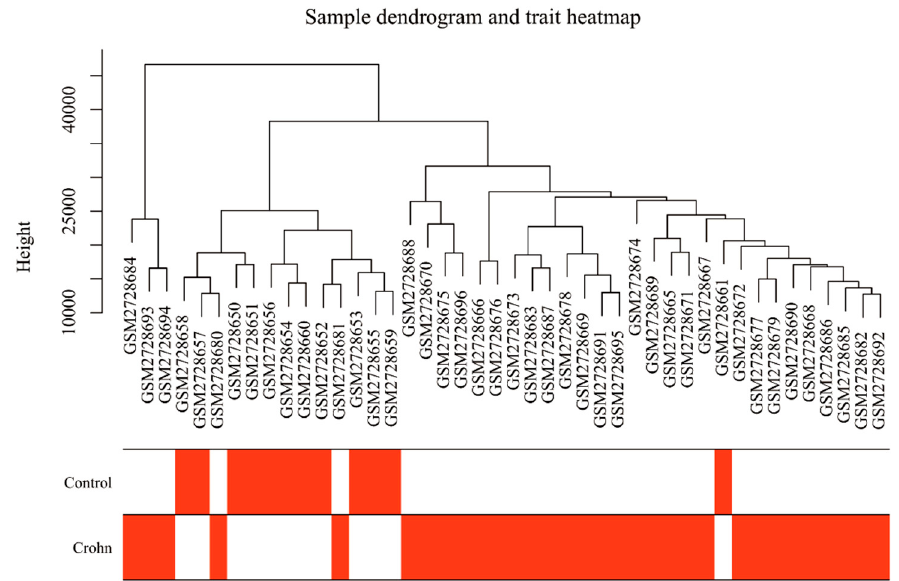
Figure 4. Sample clustering to detect outliers of GSE102134.